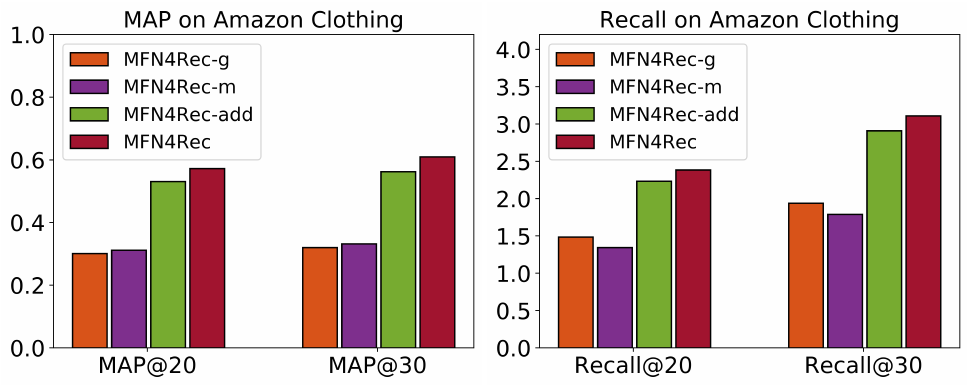
Figure 2. MAP and Recall of MFN4Rec and its